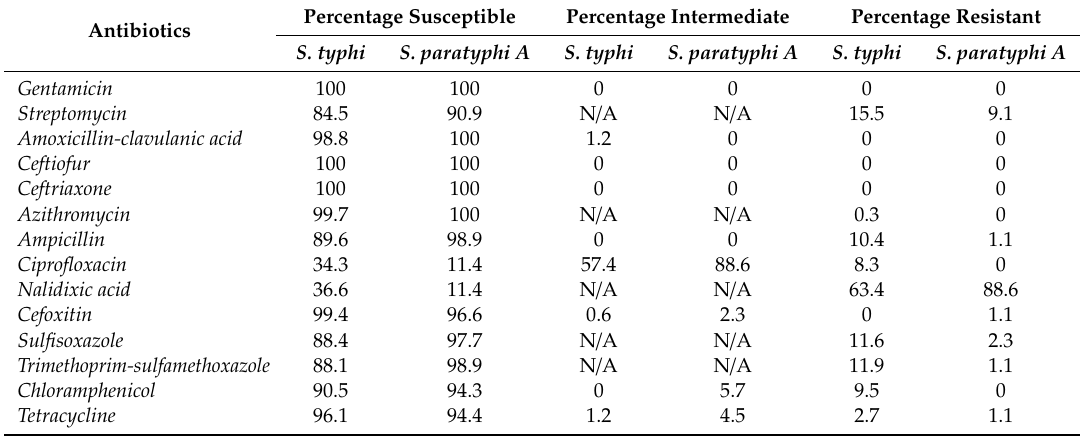
Table 2. Antimicrobial resistance pattern for Salmonella ser. Typhi (No. of isolates = 336), Paratyphi A (No. of isolates = 88), 2015 (CDC-National Antimicrobial Resistance Monitoring System-2015).